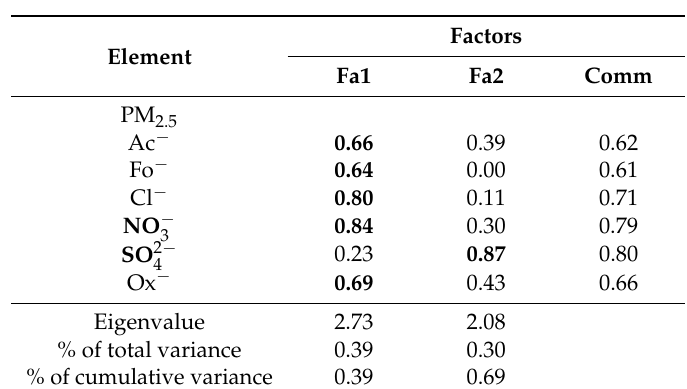
Table 6. Factor (Fa) loadings of the two extracted factors (principal component analysis, Varimax standardized rotation) for PM 2.5 samples (water-soluble ions concentration of 24-h samples in µ g/m 3 ), together with the respective communalities (comm). Loadings superior to 0.60 (in bold) are considered as